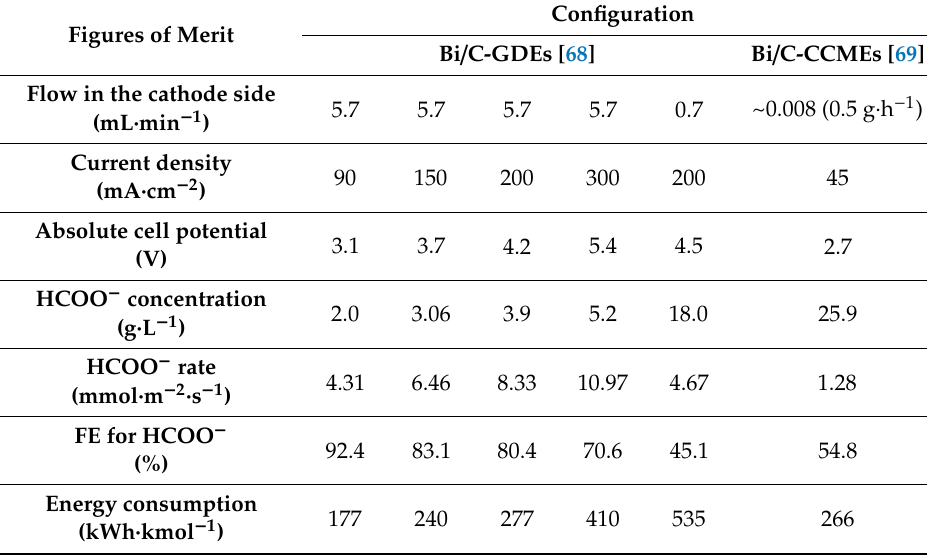
Table 2. Figures of merit (current density, HCOO − concentration, HCOO − rate, FE for HCOO − , and energy consumption per kmol of HCOO − ) for the electrocatalytic reduction of CO 2 to HCOO − employing di ff erent Bi-based electrodes (GDEs and CCMEs). Data taken from references